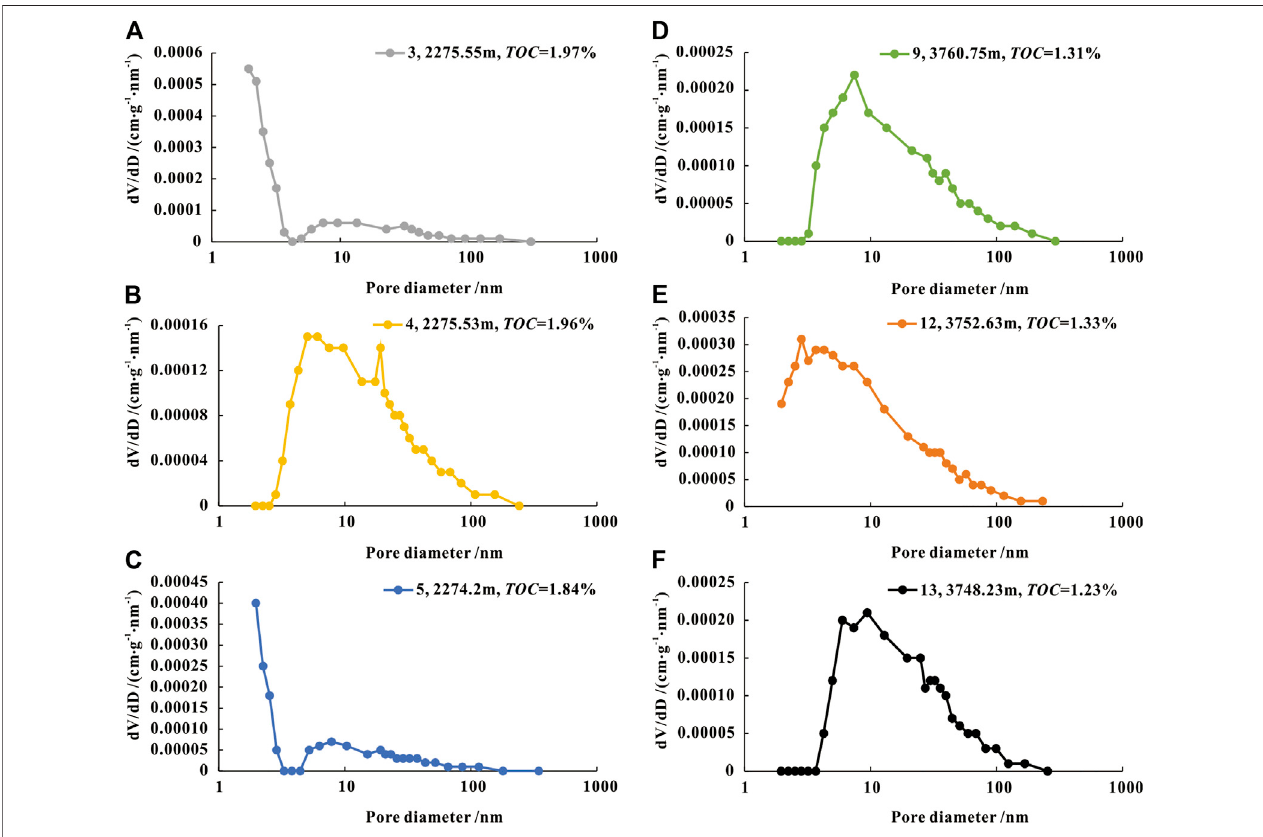
FIGURE 8 | Pore size distribution derived from N 2 adsorption analysis. (A) Dongyuemiao Member sample no. 3; (B) Dongyuemiao Member sample no. 4; (C) Dongyuemiao Member sample no. 5; (D) Da ’ anzhai Member sample no. 9; (E) Da ’ anzhai Member sample no. 12; (F) Da ’ anzhai Member sample no. 13.